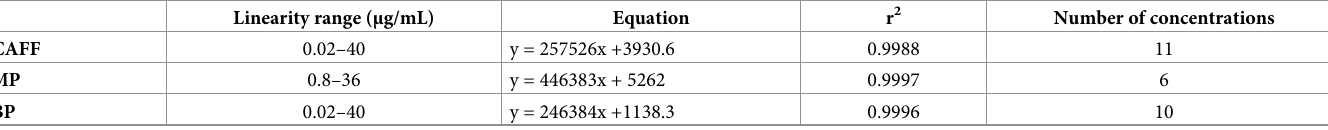
Table 2. Linearity ranges, equations, r 2 values and number of concentrations of the calibration curves for CAFF, MP and BP. Linearity range ( μ